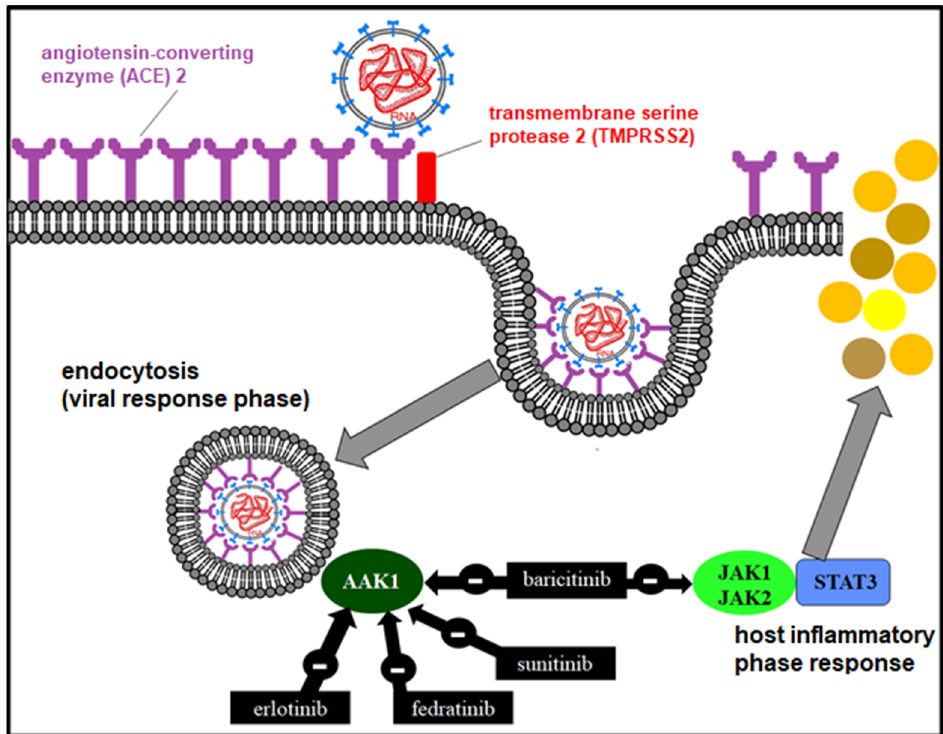
Figure 5. Mechanism of action of JAK1/2 and AAK1 inhibitors in the viral and inflammatory